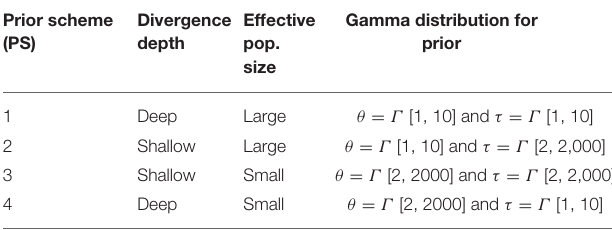
FIGURE 3 | Species tree estimated in StarBEAST2 using the mitochondrial cytochrome b and six nuclear intron dataset. Numbers above nodes indicate posterior probabilities and gray bars represent 95% highest-posterior density interval for node height. Branch lengths indicate substitutions/site. Localities refer to distribution based on available genetic data. TABLE 2 | Prior Schemes (PS) used in pairwise BPP